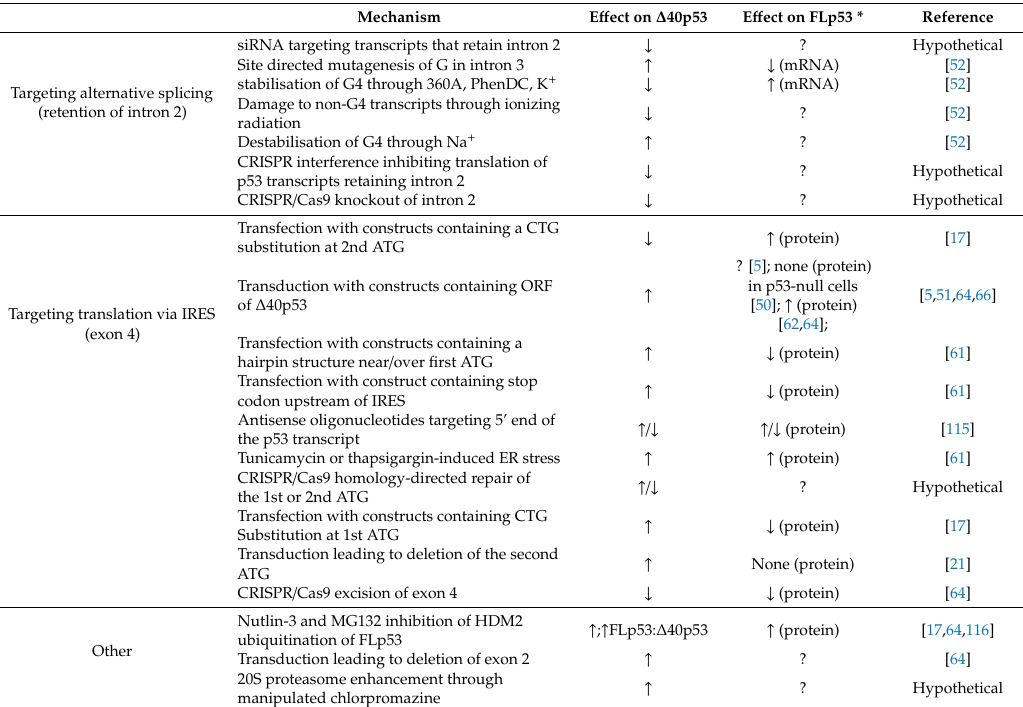
Table 2. Mechanisms to modulate ∆ 40p53